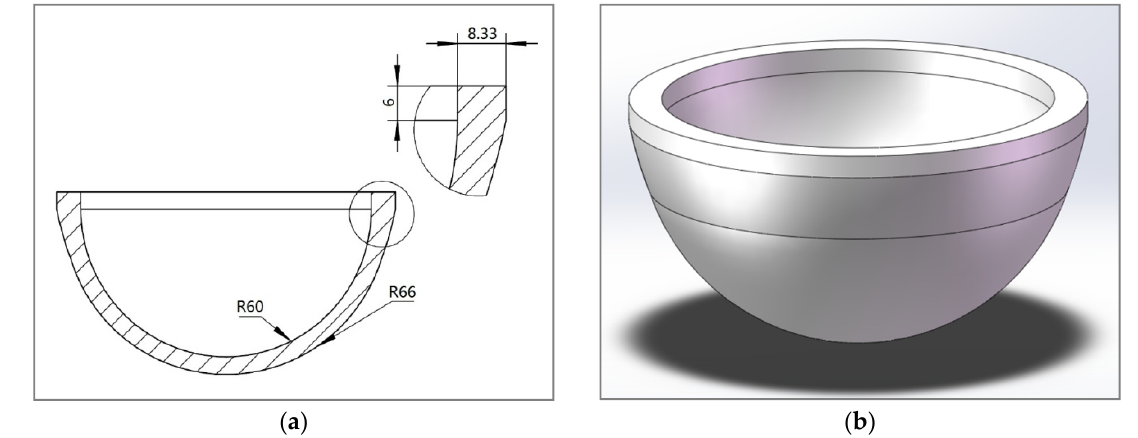
Figure 2. Technical sketch of the hemispherical greenbody. ( a ) CAD drawing; ( b ) 3D model.